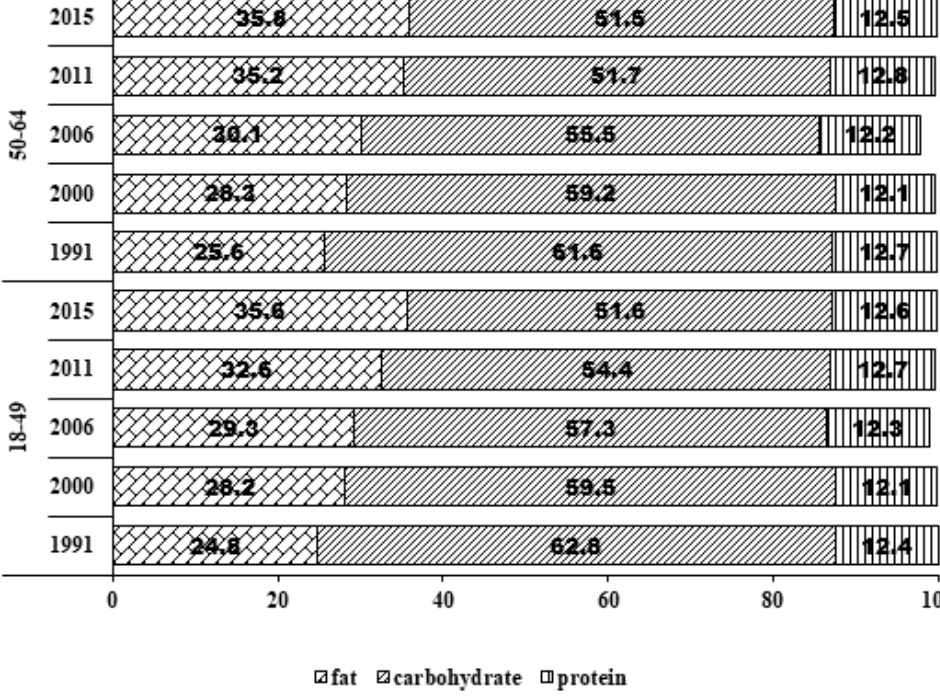
Figure 2. Percentage of energy from protein, fat, carbohydrate in Chinese adult females from 1991 to 2015 by age group (18–49 and 50–64 years).